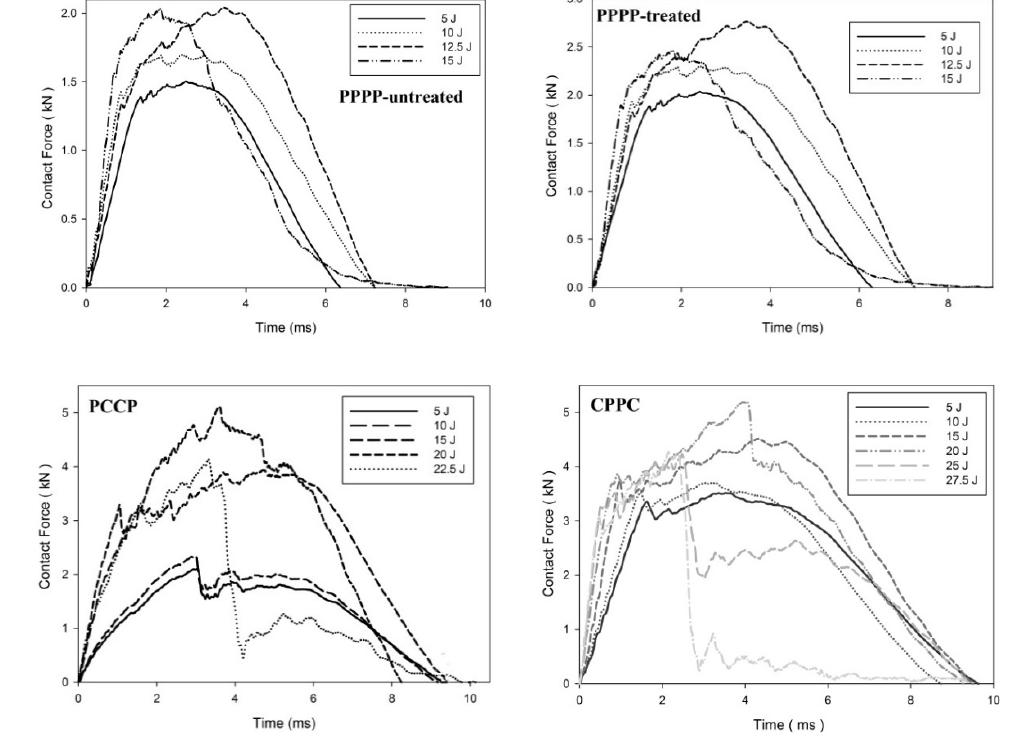
Figure 4. Contact force–time of the hybrid laminates at ply orientations of [0°, 90°] 8 .